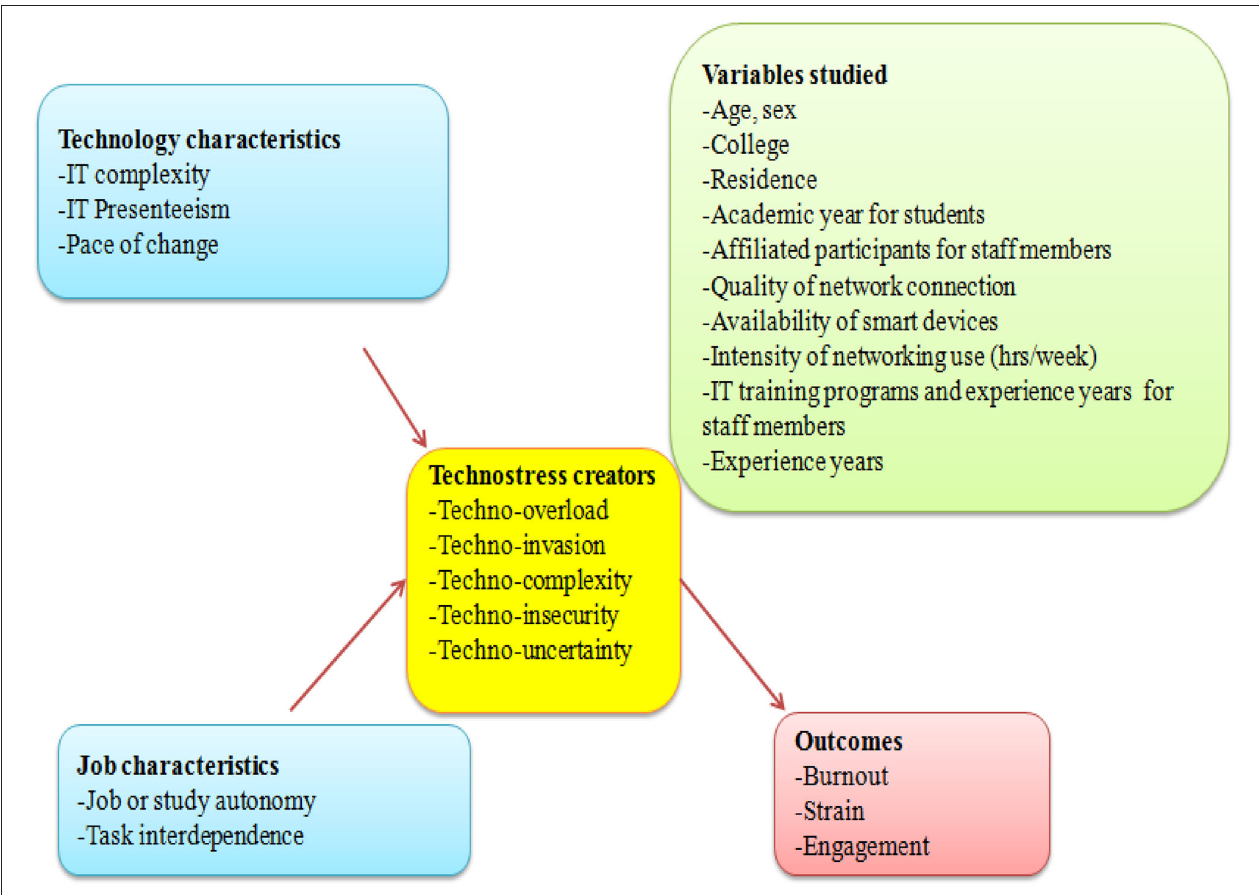
FIGURE 1 | Conceptual theoretical framework of the current